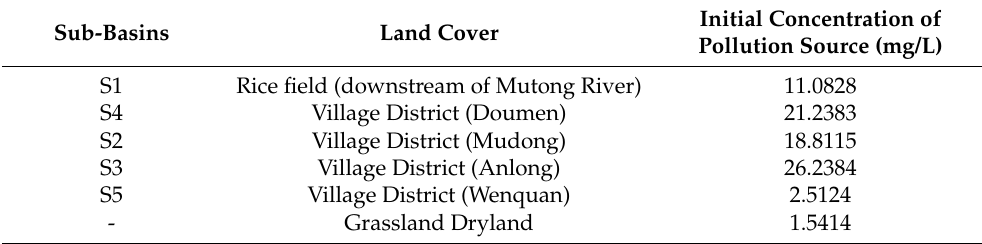
Table 2. TN initial concentration